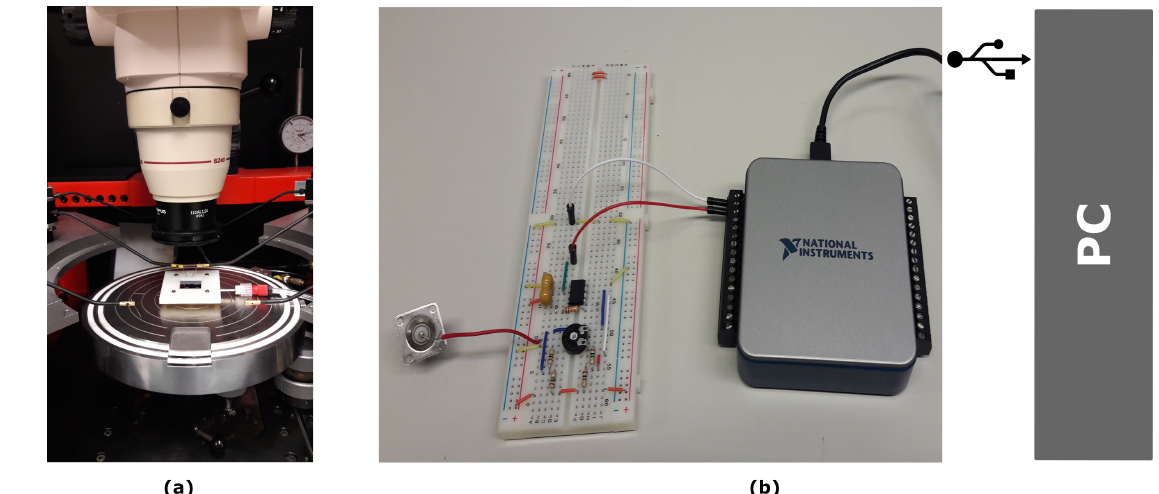
Figure 5. Measurement set-up developed to characterize the microfabricated strain gauges. ( a ) The electrical signal from the strain gauges is acquired by probing them with a standard probe station. The pneumatic actuation is provided simultaneously through a special coupling holder connected to a pressure source. ( b ) The electrical signal is conditioned and transmitted to a PC for further calculations and data